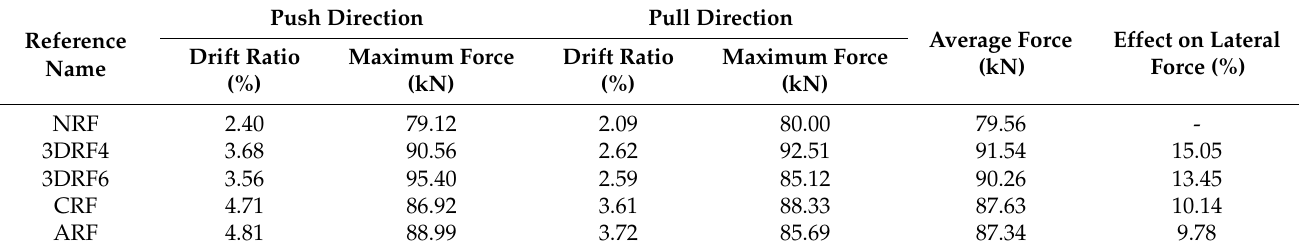
Table 4. Measured lateral